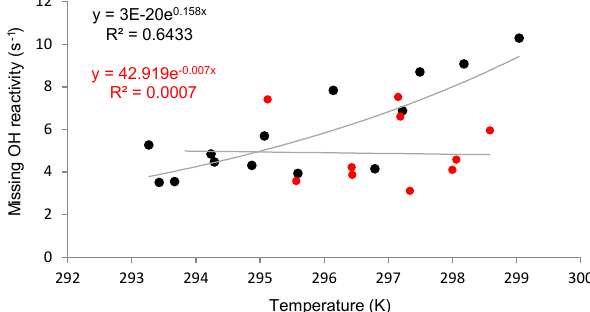
Figure 7. The temperature dependency of the difference between measured and calculated reactivity (missing OH reactivity) during 23–26 July (red data points) and 27–29 July (black data points). The missing reactivity is fitted to E(T ) = E (293)exp (β(T − 293)). The exponential curve fits the black markers, while the close-to-straight line fits the red